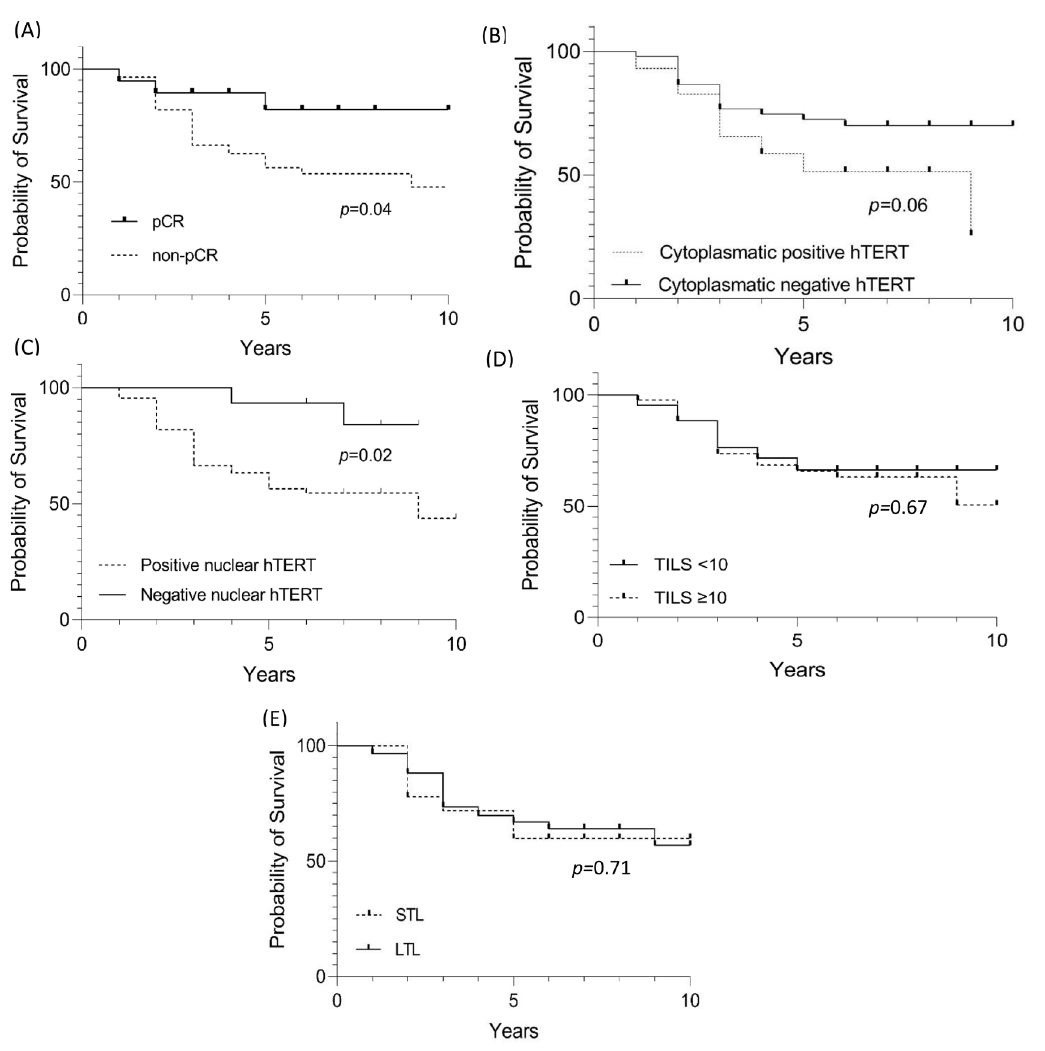
Figure 3. Survival evaluation for HER-E cases with pCR, hTERT cytoplasmic and nuclear staining, TILs, and LTL. ( A ) Evaluation of significant value in the survival of HER-2 cases with pCR. ( B ) Evaluation of significant value in the survival of HER-2 cases with hTERT cytoplasmic staining. ( C ) Evaluation of significant value in the survival of HER-2 cases with hTERT nuclear staining. ( D ) Evaluation of significant value in the survival of HER-2 cases with TILs. ( E ) Evaluation of